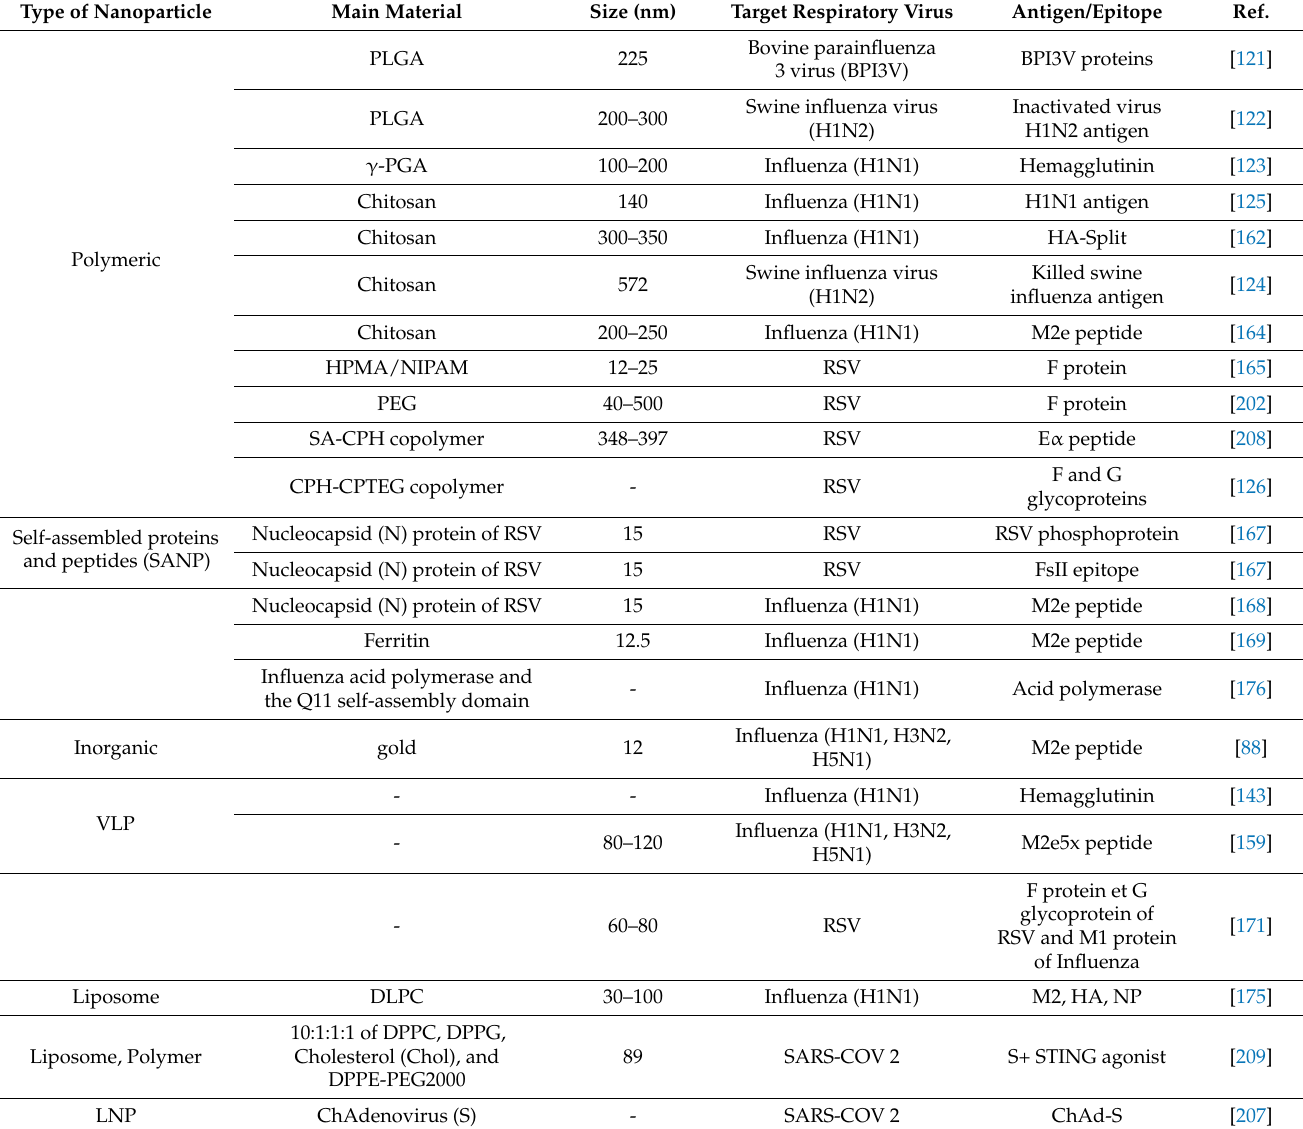
Table 3. Nano-vaccines developed for intranasal delivery in viral respiratory